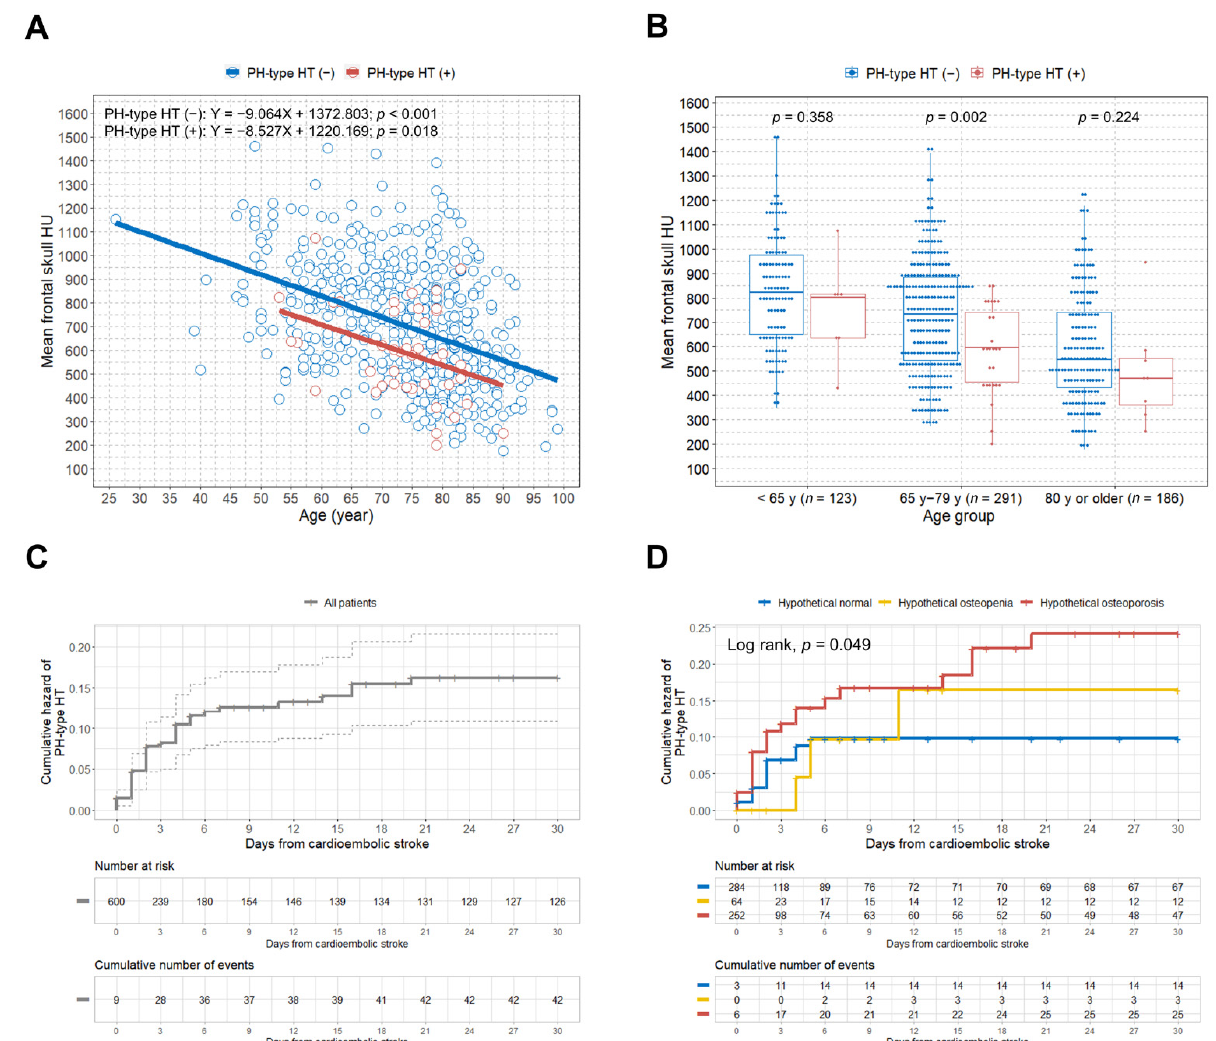
Figure 2. Scatterplot with linear regression lines, boxplots, and Kaplan–Meier curves in the study patients. ( A ) Scatterplot with linear regression lines showing the association between age and mean frontal skull HU values based on the presence of PH-type HT; ( B ) boxplots with dot plots of the mean frontal skull HU values classified by age group according to the presence of PH-type HT; ( C ) overall cumulative hazard of PH-type HT development; ( D ) cumulative hazard of PH-type HT development according to the hypothetical BMD groups. HU = Hounsfield unit; PH = parenchymal hematoma; HT = hemorrhagic transformation; BMD = bone mineral density.